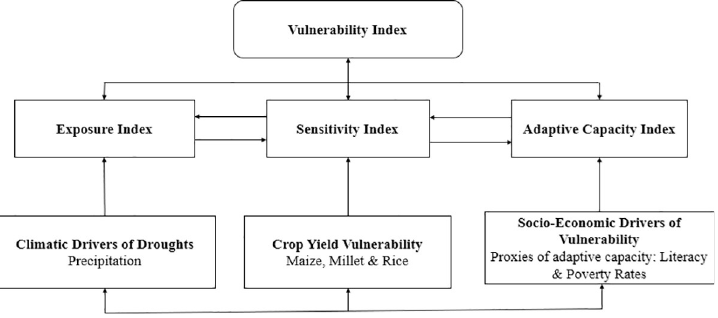
Fig 1. Schematic representation of the vulnerability conceptual framework. Source: Authors’ conceptualization.